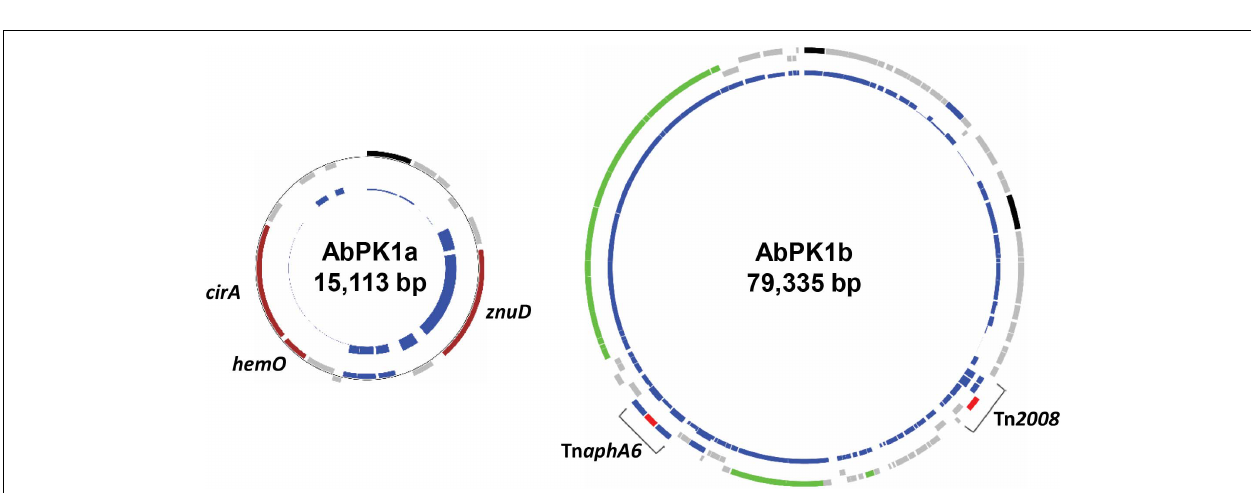
FIGURE 4 | Pathogenicity Island 1 carrying siderophore cluster 3. The entire island consisting of Tn 6171 with target site duplication “GCCTT” was found present in 44 out of 2283 (1.9%) analyzed A. baumannii genomes. brown: siderophore biosynthesis genes; gray: hypothetical protein genes; green: efflux pump genes; blue: IS elements; orange: transposition gene cluster; black: flanking genes present in all genomes.